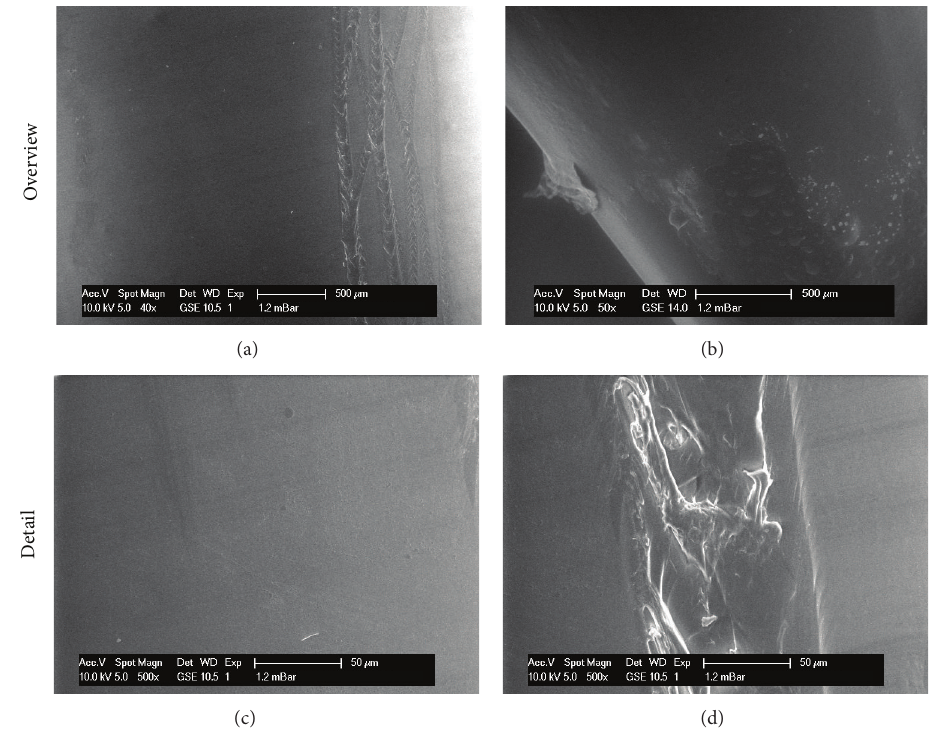
Figure5:RepresentativeESEMmicrographsofEDC/NHS-crosslinkedHAcoatingson(a),(c),and(d)GPTMS-modifiedand(b)unmodified surfaces. The scratch on GPTMS-modified surfaces (a) and (d) has been done intentionally for a better visualization of the